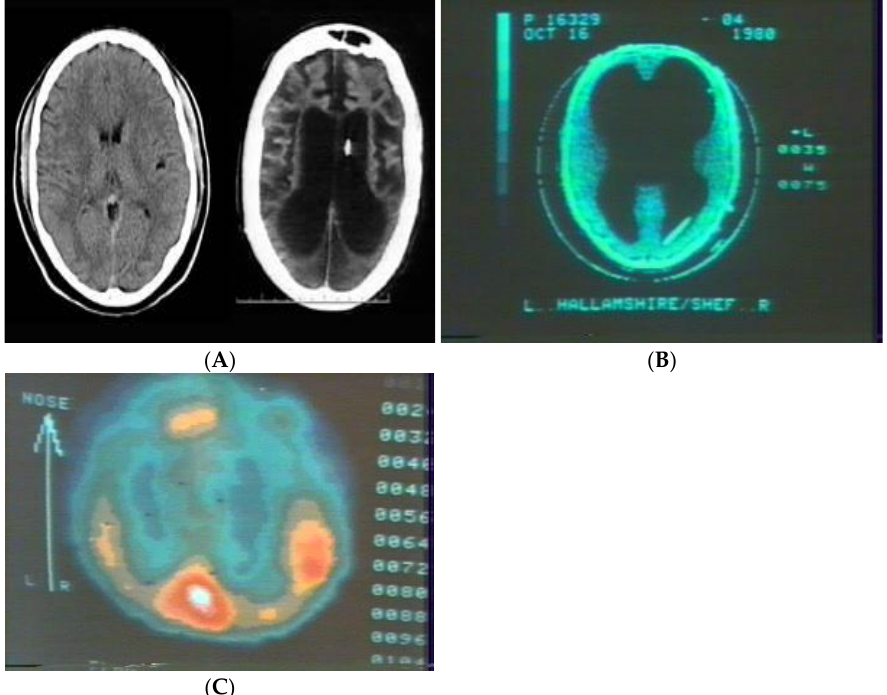
Figure 1. ( A ) Normal CT-scan (Left) and that of patient T.S. in persistent vegetative state resulting from anoxia during childbirth (Right). ( B ) CT of congenitally hydrocephalic individual within the normal to above average range of intellectual capacity. ( C ) Xe-gas regional cerebral blood flow of individual in ( B ) while performing mental